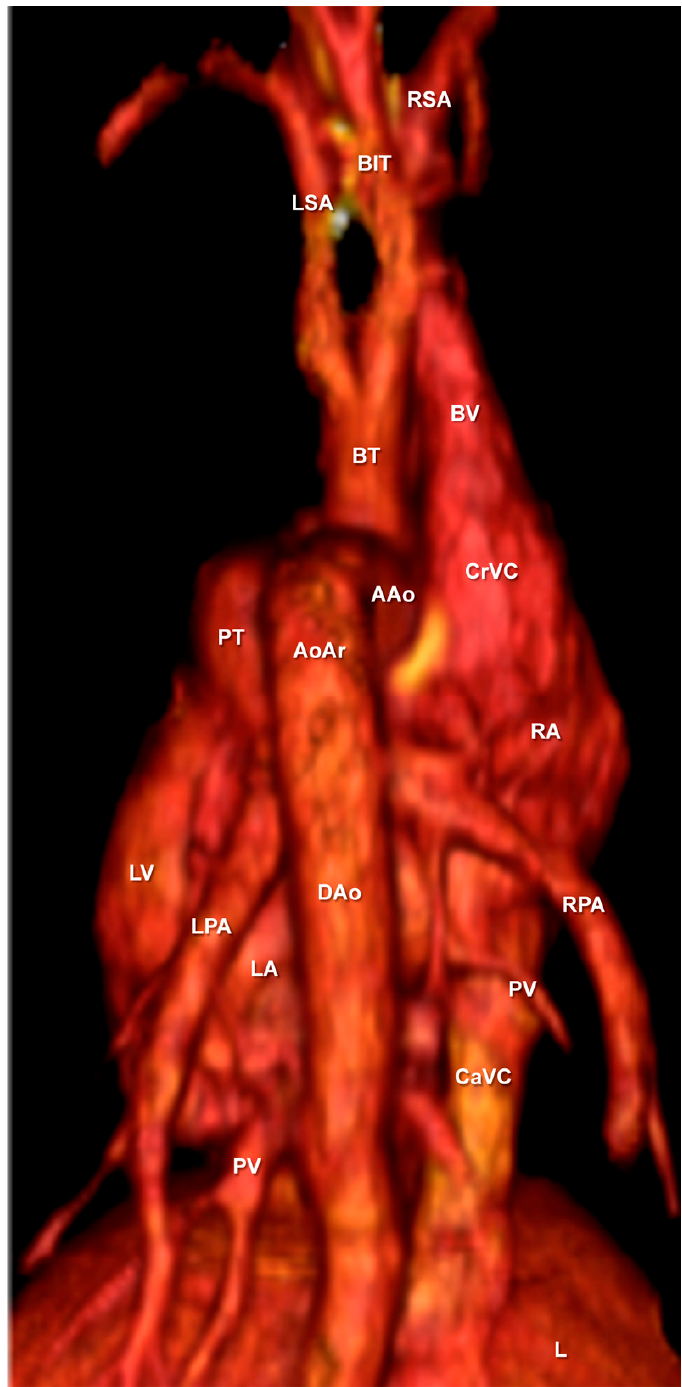
Figure 10. Three-dimensional volume-rendered reconstructed image of the normal neonatal foal heart and associated blood vessels. Dorsal aspect. Aortic arch (AoAr); ascending aorta (AAo); bicarotid trunk (BIT); brachiocephalic trunk (BT); brachiocephalic vein (BV); caudal vena cava (CaVC); cranial vena cava (CrVC); descending aorta (Dao); left atrium (LA); left pulmonary artery (LPA); left subclavian artery (LSA); left ventricle (LV); liver (L); pulmonary trunk (PT); pulmonary vein (PV); right atrium (RA); right azygos vein (RAV); right pulmonary artery (RPA); and right subclavian artery (RSA).